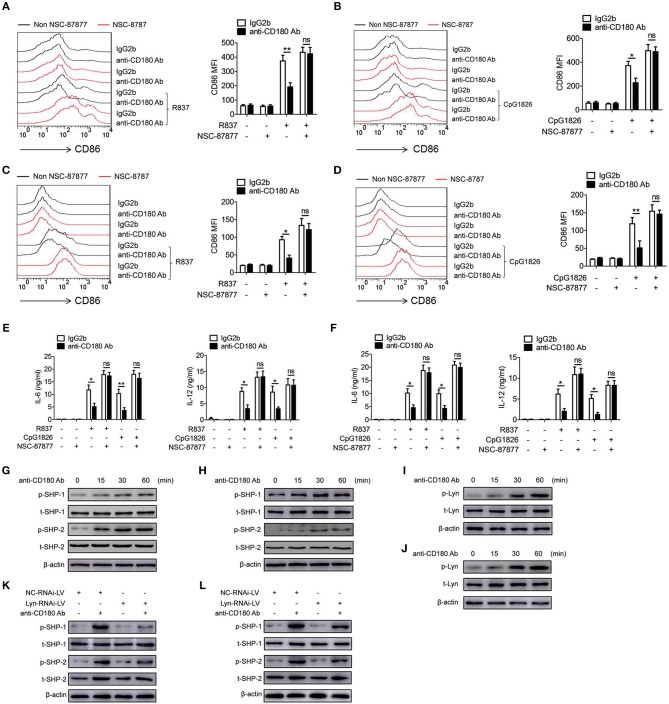
Lyn-SHP-1/2 axis is required for the inhibitory effect of CD180 on TLR7- and TLR9-mediated activation of macrophages and DCs. (A–F) BMDMs and BMDCs were pretreated with NSC87877 (1 μM) for 1 h followed by stimulation with anti-CD180 Ab (0.2 μg/ml). Then the cells were stimulated with R837 (1 μg/ml) and CpG 1826 (0.5 μM). Flow cytometric analysis of CD86 expression on BMDMs (A,B) and BMDCs (C,D) at 24 h. ELISA analysis of the levels of IL-6 and IL-12 secreted by BMDMs (E) and BMDCs (F) at 24 h. (G,H) BMDMs (G), or BMDCs (H) were stimulated with anti-CD180 antibody (0.2 μg/ml) for different times and western blot analysis of the phosphorylation levels of SHP-1 and SHP-2. (I,J) BMDMs (I) or BMDCs (J) were stimulated with anti-CD180 antibody (0.2 μg/ml) for different times and western blot analysis of the phosphorylation levels of Lyn. (K,L) BMDMs (K) and BMDCs (L), which have been infected with lentivirus expressing negative control-RNAi (NC-RNAi-LV) or Lyn-specific RNAi (Lyn-RNAi-LV), were stimulated with anti-CD180 antibody (0.2 μg/ml) for different times and western blot analysis of the phosphorylation levels of SHP-1 and SHP-2. The data shown represent the means of three independent experiments and the error bars represent the S.E.M. *p < 0.05, **p < 0.01, as determined by ANOVA tests; ns denotes p > 0.05.